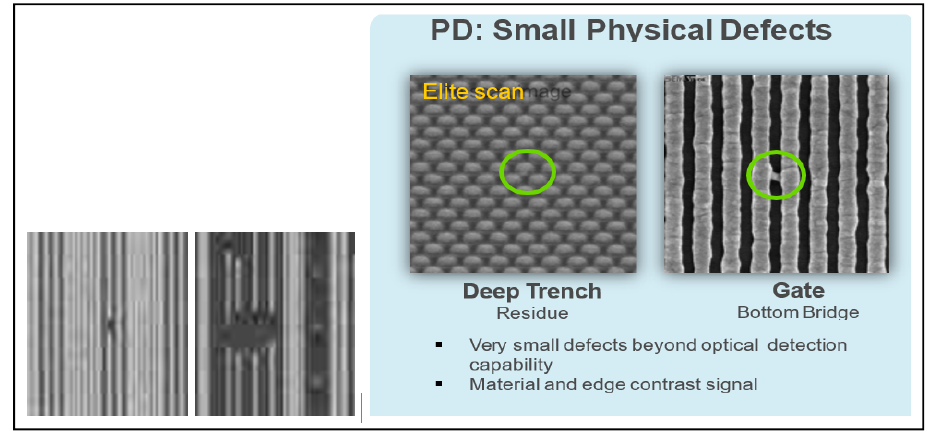
Figure 10. Physical defects detected by edge contrast signal using E-beam.